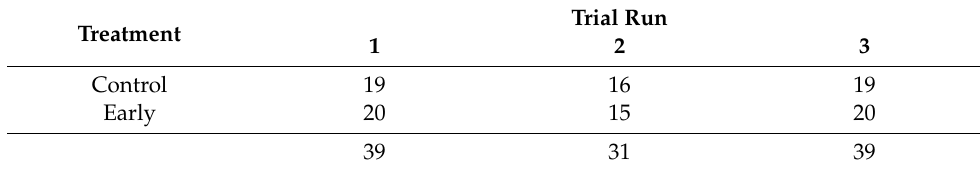
Table A1. Number of animals per treatment and trial run.